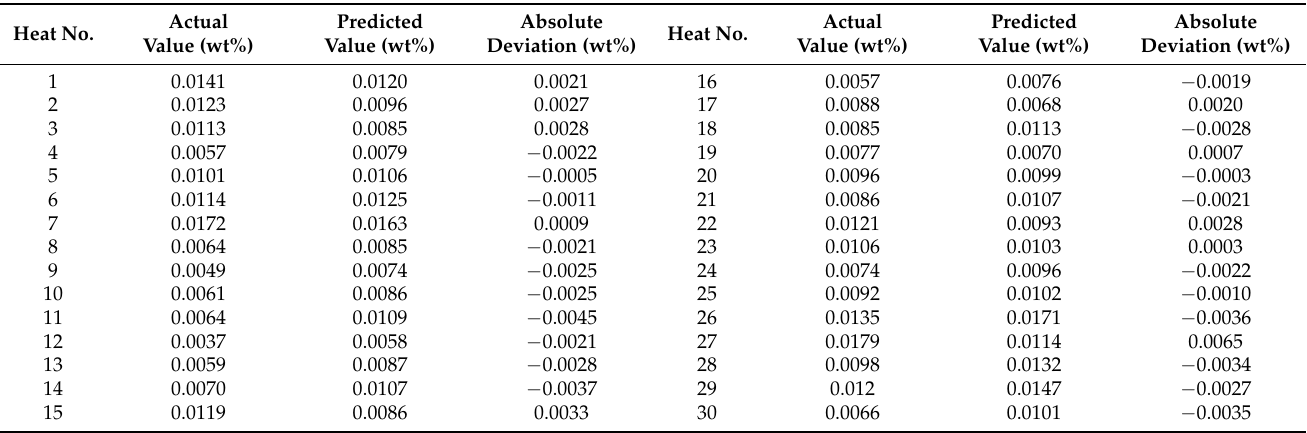
Table 6. Results for prediction system of end-point P content.